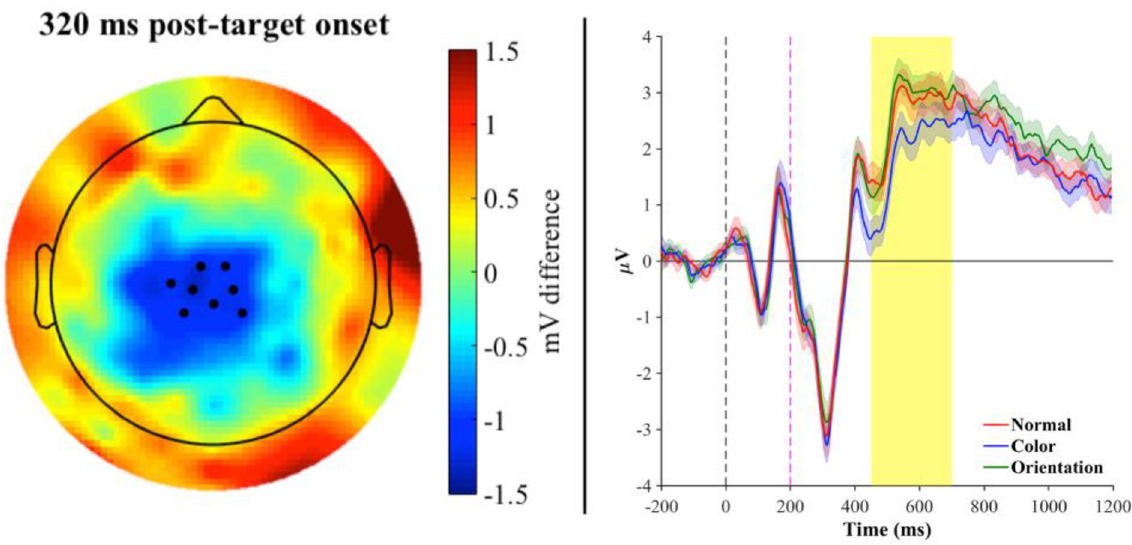
Fig 3. Left panel : Topographic map of the brain at peak channel significance (~320 ms post-target onset) for Color—Orientation trials of the natural category . Topography reflects the difference between the grand average for Color—Orientation trials, black dots represent the 8 unique significant electrodes at p < 0.001. Right panel : Mean waveforms across the 8-electrode cluster plotted separately for the normal (red), color (blue), and orientation (green) conditions. Significance reflects the difference between the color and orientation condition (normal is also plotted for visualization of the pattern of effect). The black dashed line represents onset of the prime and the pink dashed line represents onset of the target. Shaded regions along the waveforms indicate standard error of the mean. The shaded yellow bar denotes significant time points within the N400 time window. The color condition, compared to the orientation condition, elicited the canonical N400. Note: The shaded yellow bar begins at 450ms (corresponding to 250ms post-target onset) due to the 0 time point on the x-axis being locked to the prime onset.